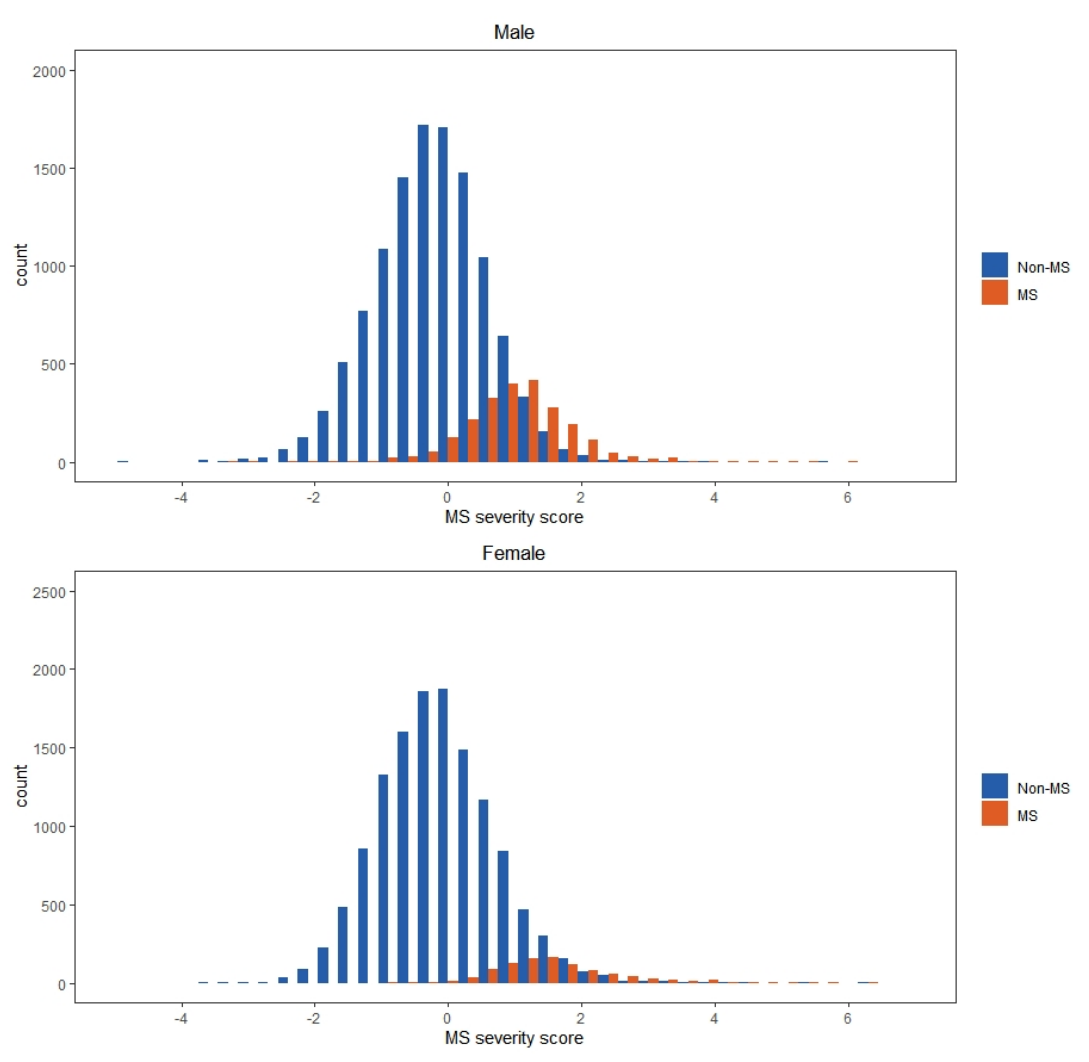
Figure 1. Distributions of MS severity scores in men and women.